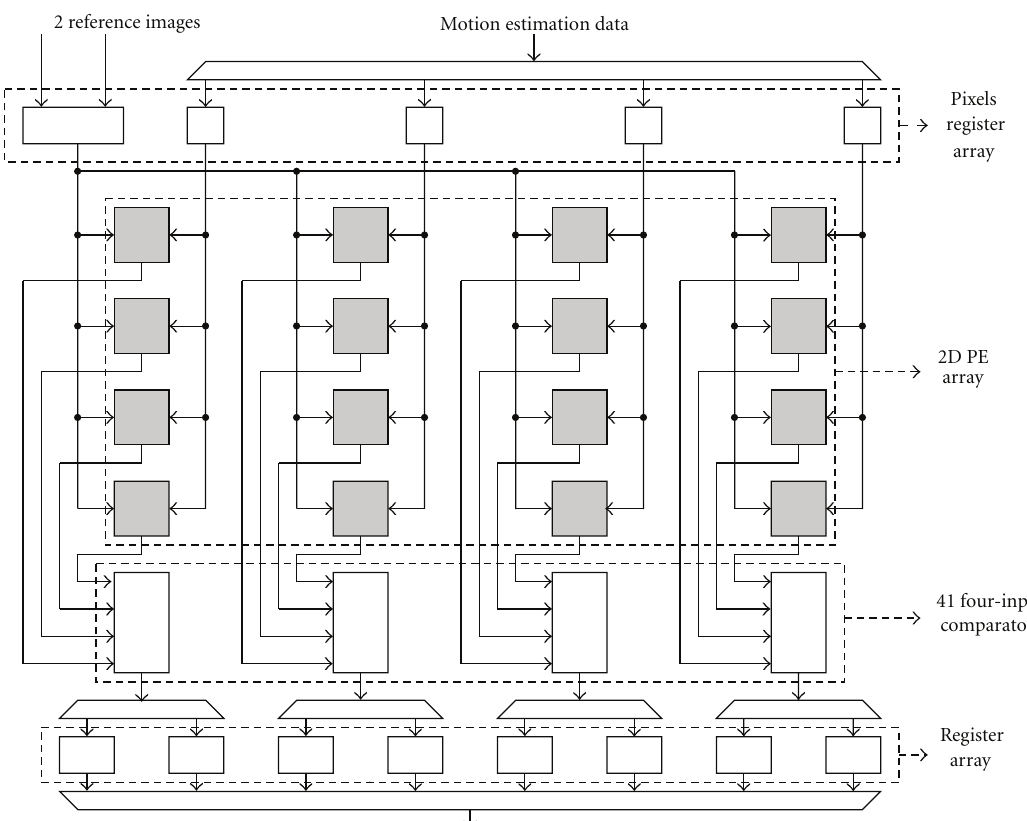
Figure 7: Block diagram of an integer motion estimator design with a macroblock parallel architecture and sixteen 2D PE arrays [23].